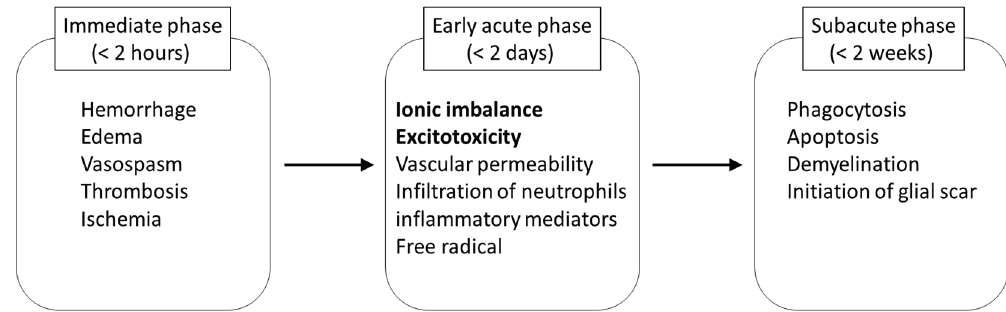
Figure 3. Key pathological events in secondary injury of spinal cord ionic imbalance and excitotoxicity are the targets in riluzole